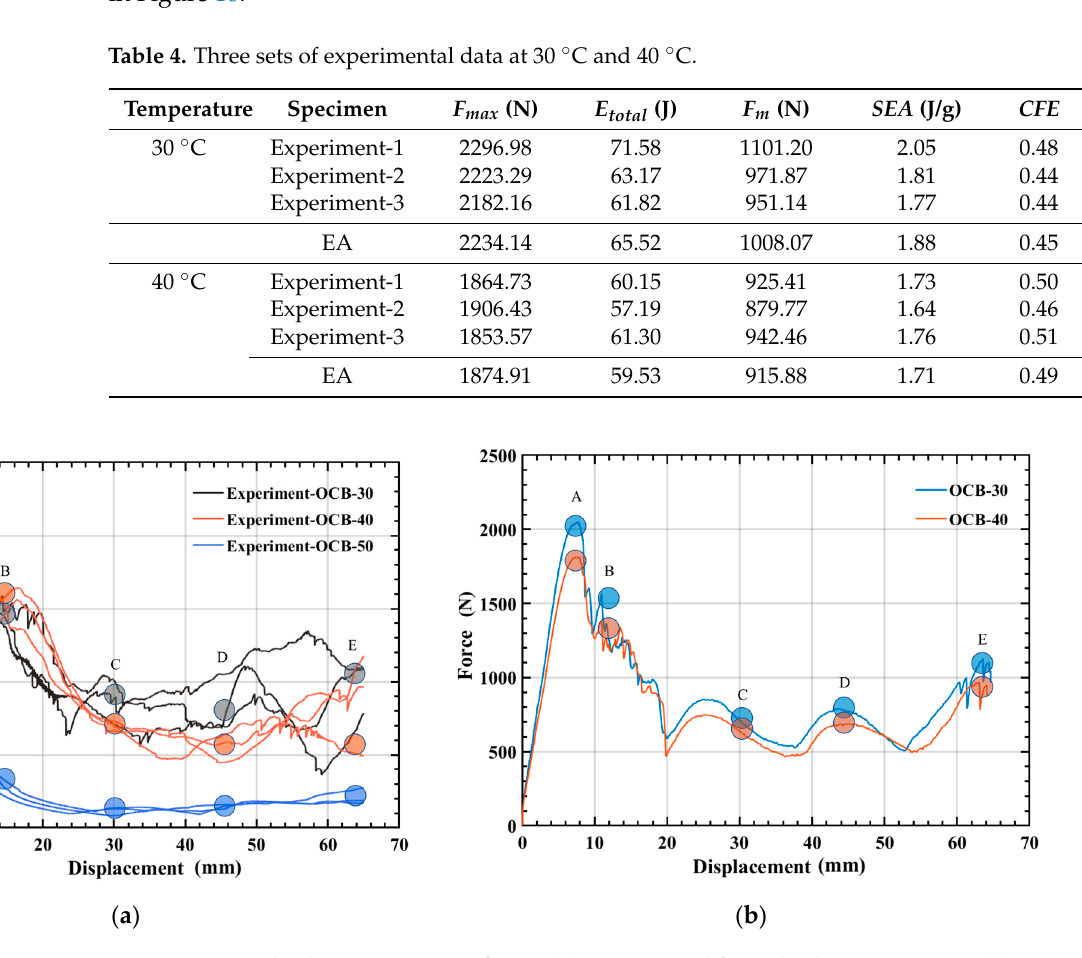
Figure 9. Force-displacement curves of OCB: ( a ) experimental force-displacement curves; ( b ) numerical force-displacement curve. Table 5. Energy absorption indexes at different